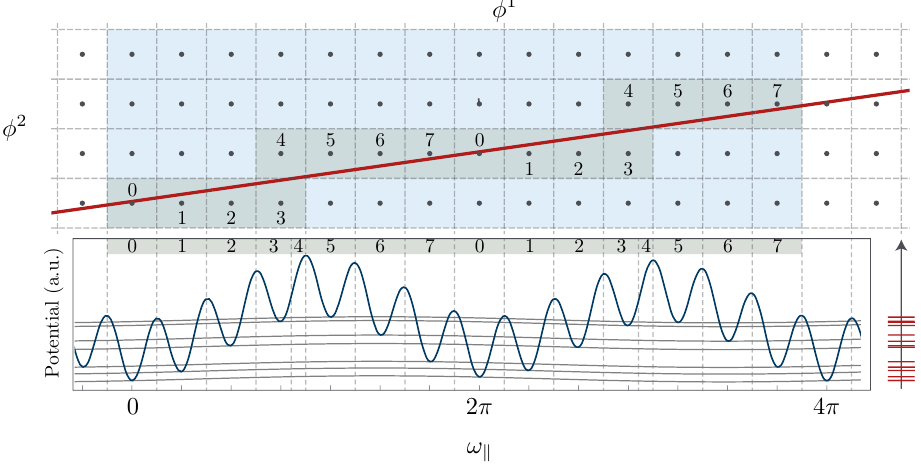
Figure 10 . Top : constraint surface (red line) along with the lattice 2 (cid:25) Z P (gray dots). Distinct tiles of the leading cosine terms are numbered and shaded dark, while the periodicity of the subleading terms is indicated by the light shading. Bottom : axion potential. The subleading terms further split the energies in the minima of the leading